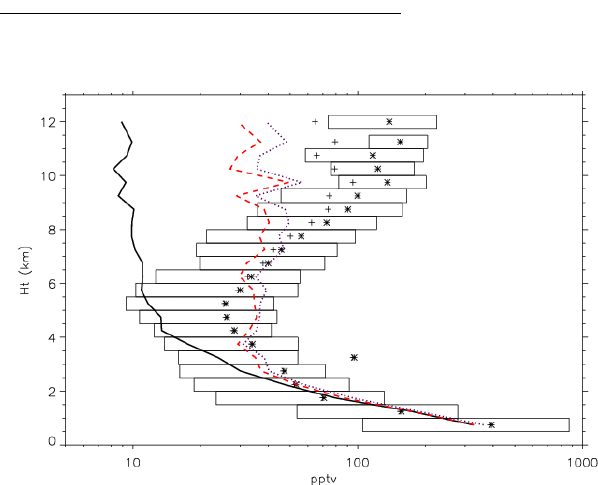
Figure 15. Vertical distribution of NO 2 during INTEX-A. Means of medians from 16 DC-8 flights are shown by asterisks (“+” symbols) before (after) adjustment for MPN and HO 2 NO 2 interference. Box edges show mean 10 th and 90 th percentiles for the 16 flights. Model means of medians from simulations noL (solid black line), LNO x (dashed red line), and LNO x adjChem (purple dotted line) are also shown.